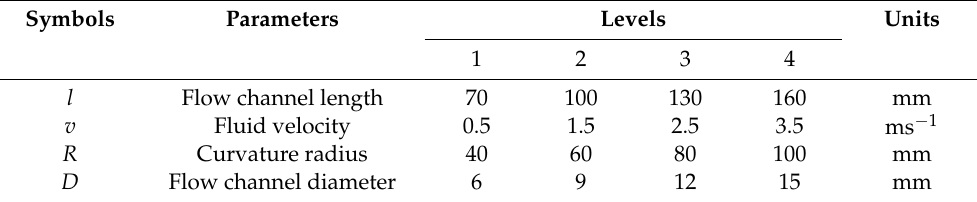
Table 2. Flow channel design parameters and their corresponding values with levels.